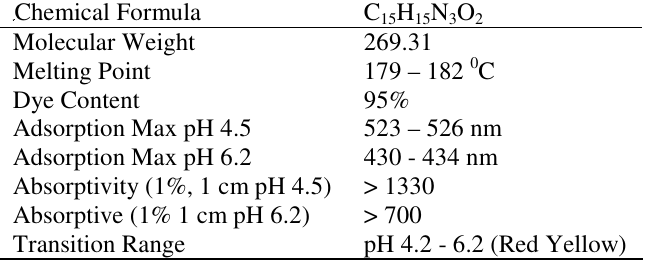
Table 2. Characteristic of the methylene red.